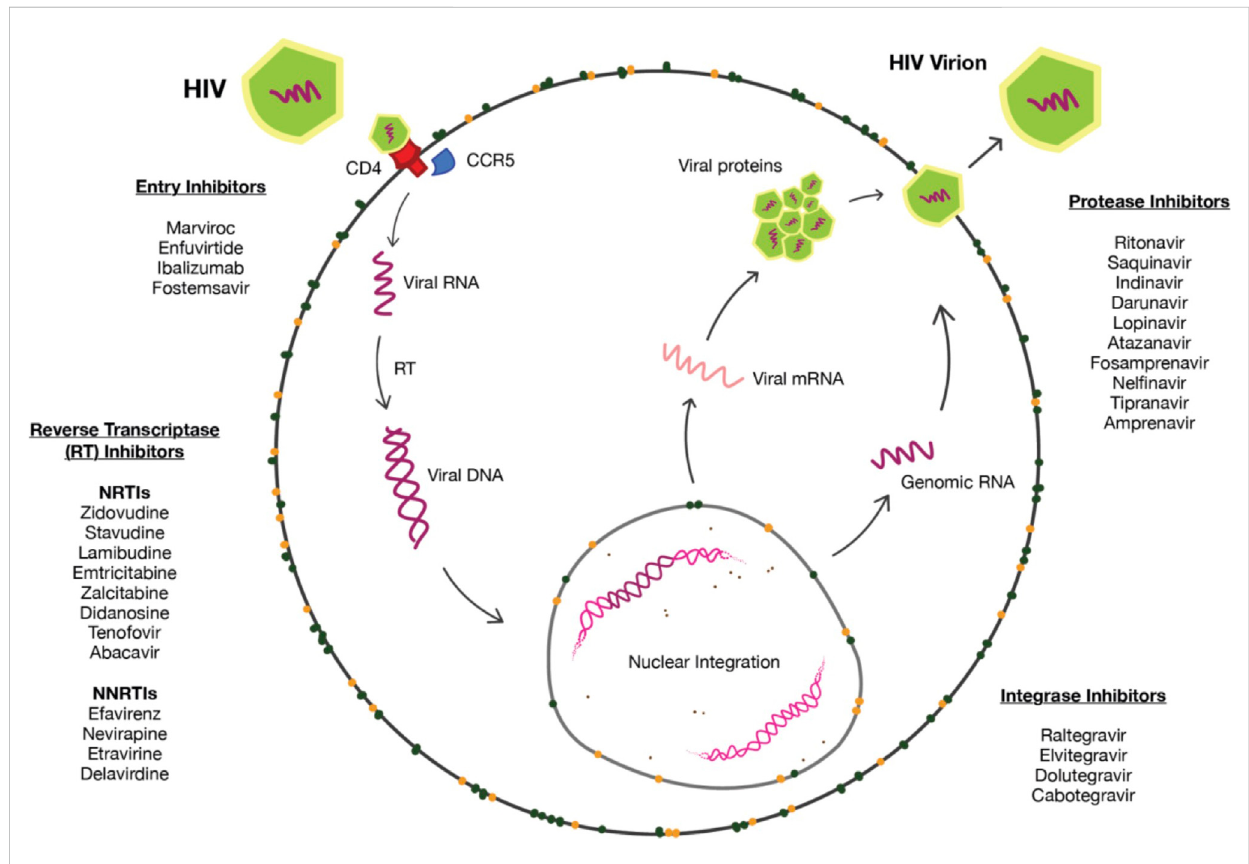
FIGURE 1 HIV pharmacological